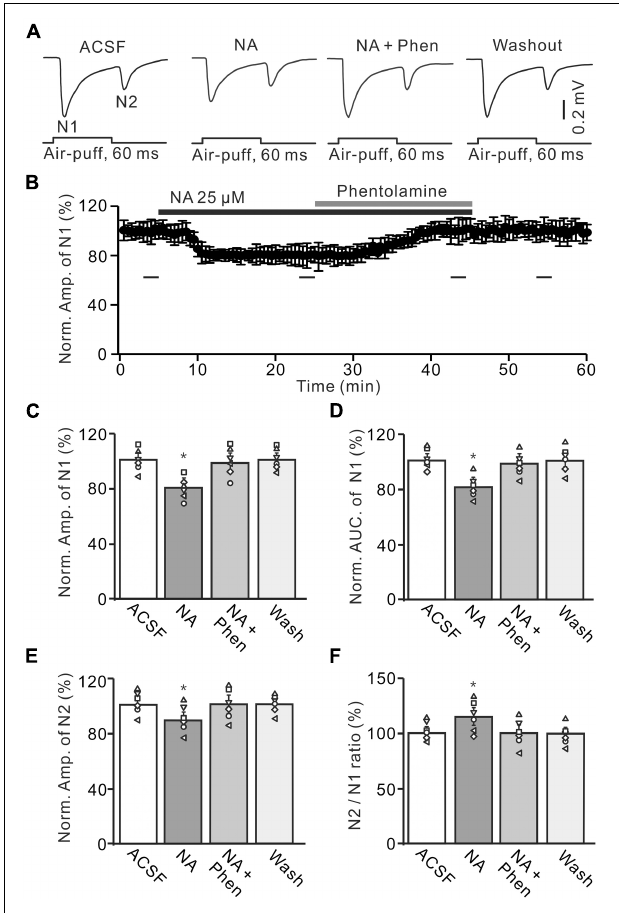
FIGURE 2 | Application of α -adrenoceptor (AR) antagonist reverses the NA-induced depression of the facial stimulation-evoked MF-GC synaptic transmission. (A) Representative field potential traces showing the facial stimulation (60 ms, 60 psi) evoked MF-GC synaptic transmission in a mouse cerebellar GL during treatment with ACSF, NA (25 µ M), NA + phentolamine (Phen; 100 µ M), and recovery (washout). (B) Summary of data showing the time course of normalized amplitude of N1 during treatment with ACSF, NA (25 µ M), NA + phentolamine (Phen; 100 µ M) and recovery (washout). Bars denote the data points which were used in the bar graphs (C–F) in treatments with ACSF, NA, NA + phentolamine and washout. (C,D) Mean value ( ± SEM) with individual data showing the normalized amplitude (C) and AUC (D) of N1 during each treatment, NA, NA + Phen and recovery (washout). (E,F) Mean value ( ± SEM) with individual data showing the normalized amplitude of N2 (E) and the N2/N1 ratio (F) during each treatment. Note that application of phentolamine reversed the NA induced-inhibition of facial stimulation-evoked MF-GC synaptic transmission. * p < 0.05 versus control (ACSF); n = 6 in